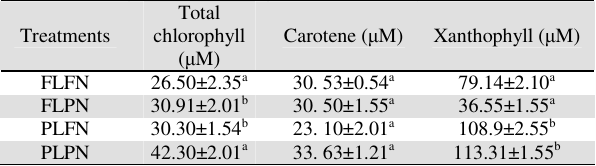
Mean ± (SE) values followed by the same letter within each column are not significantly different at 0.05(ANOVA and Duncan’s multiple range